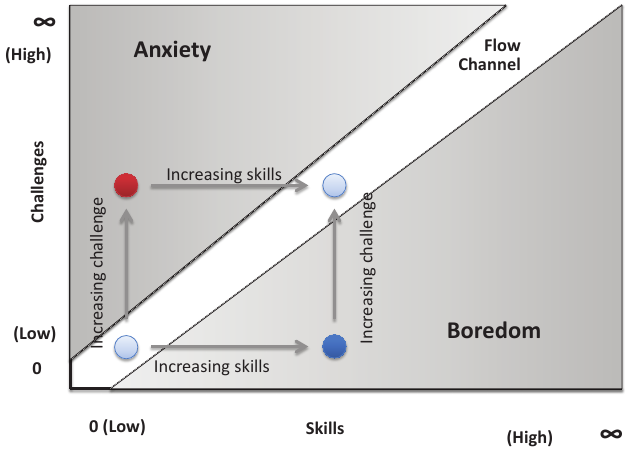
Fig. 2. The state of flow is achieved between anxiety and boredom (Xu,